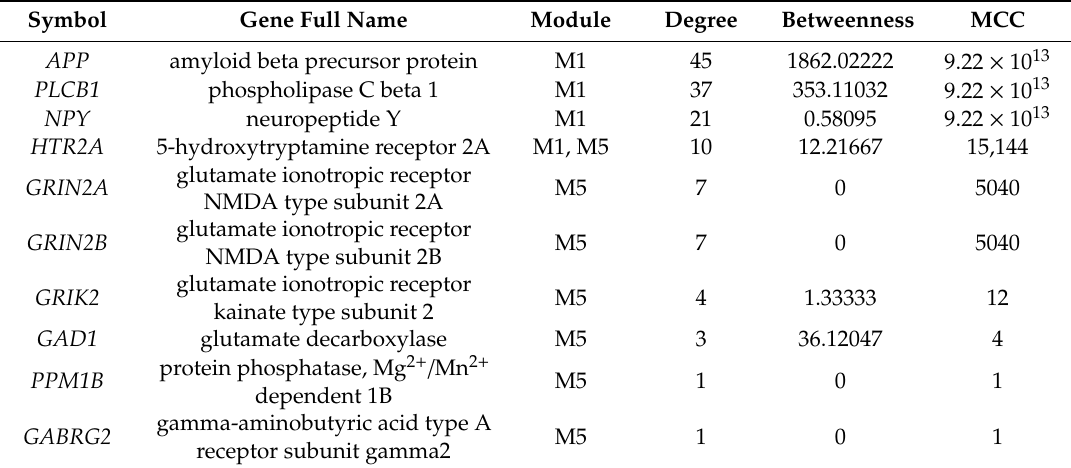
Figure 6. Top two delirium-relevant PPI modules, M1 and M5, prioritized by enrichment analysis. Nodes represent delirium-associated genes, and the node size is proportional to its degree. Node color (from lighter to darker) is proportional to the number of chemicals supporting chemical–gene interactions associated with delirium. The circles with thick red borders represent HAR-Brain genes. Table 1. HAR-Brain genes found in the M1 and M5